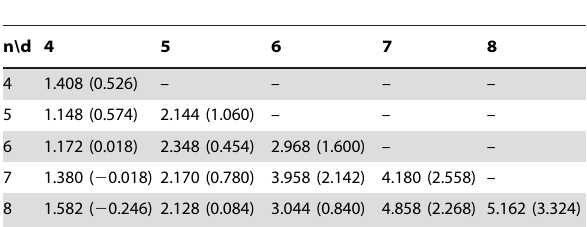
Table 1. Data with two combinatorial constraints.